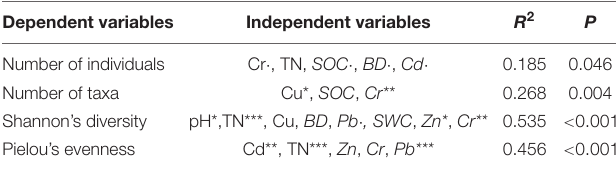
TABLE 1 | Results from all-subset linear regression analysis relating soil fauna biodiversity to soil physicochemical characteristic. Dependent